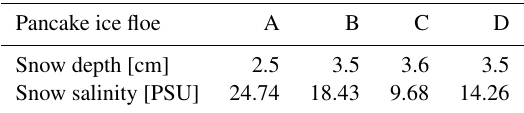
Table 3. Overview of pancake ice floe snow depth and